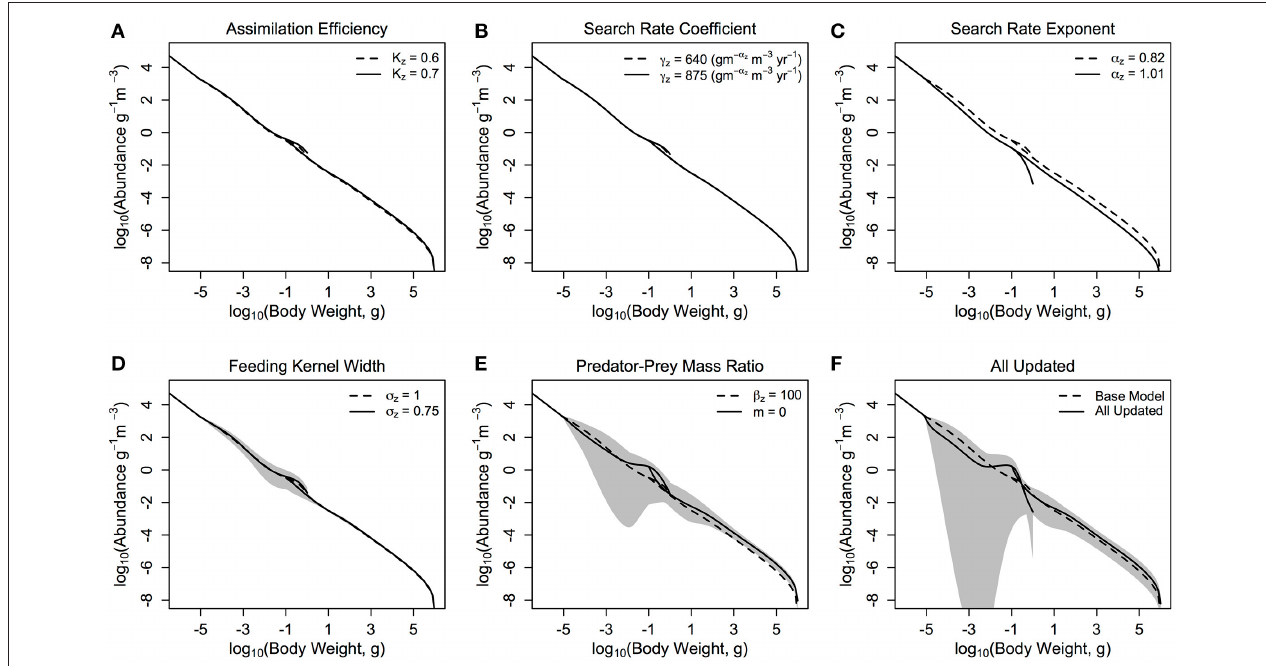
FIGURE 3 | The zooplankton and fish community size-spectra when various parameters are updated (A–E) one at a time and (F) all together. The dashed lines in each plot represent the zooplankton and fish communities in the base model parameterization, and the solid lines denotes the average abundance of the fish and zooplankton communities over 10 years in the modified model. The shaded areas show the regions of the traveling wave solutions over 10 years if the steady state is unstable.